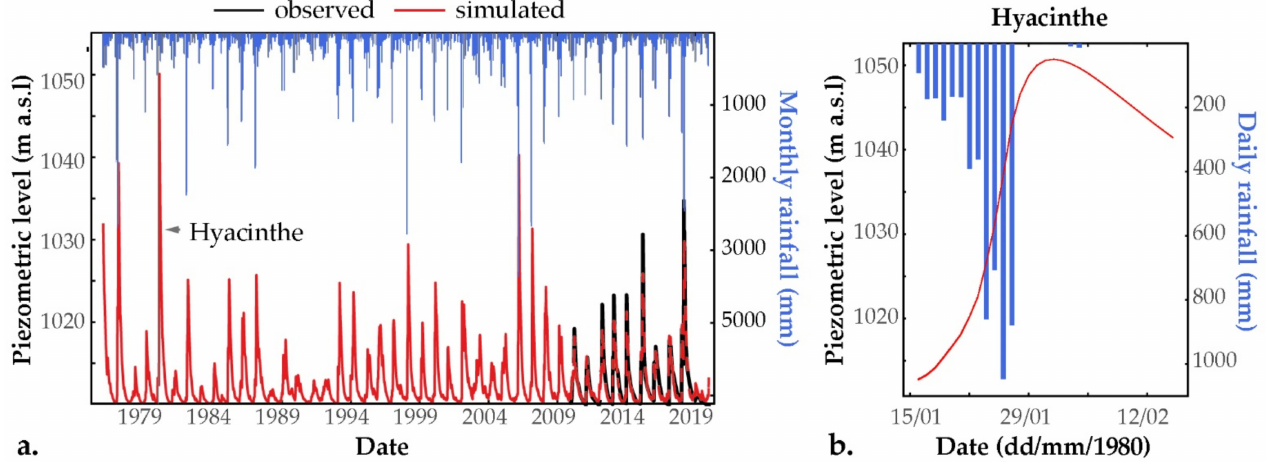
Figure 6. Rainfall recorded in Grand Ilet and piezometric level variation at PZA3 (see Figure 2) ( a ) from 1976 to 2020 and ( b ) during Cyclone Hyacinthe (15–27 January 1980). Blue bars are the rainfall; black and red lines are, respectively, the recorded and the hindcast water-levels since 1976. a.s.l. = above sea